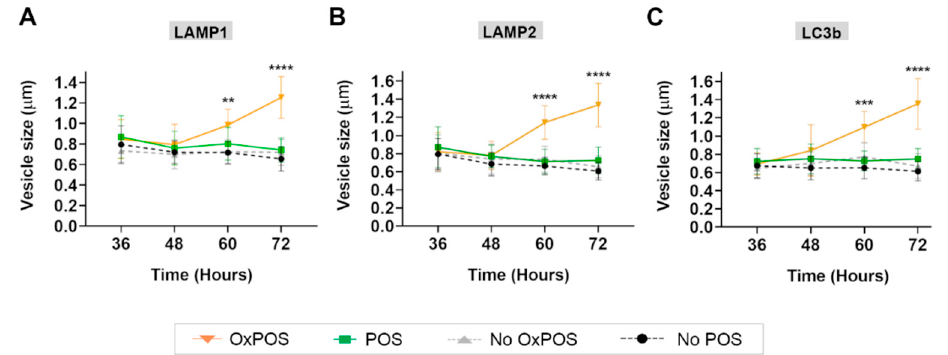
Figure 3. The effects of different cargo-types on the size of autophagy-lysosomes in RPE cells. The diameter of vesicles with and without POS or OxPOS was quantified in blinded confocal images at late time points and shown for ( A ) LAMP1, ( B ) LAMP2 and ( C ) LC3b. Significant differences were observed showing OxPOS associated with enlarged early and mature lysosomes at 60–72 h, compared to equivalent compartments without cargos in the same culture. Similarly, LC3b bodies trafficking OxPOS were also swollen by 60–72 h compared to autophagy vacuoles without these cargos in the same culture. The extent of swelling in OxPOS-carrying vesicles was considerable, which significantly increased in diameter compared to vesicles carrying POS or those without any cargos. Data from a minimum of 5 measurements from each of 9 fields of view and at least n = 10 cells/field per time point. Statistical comparisons using a two-way ANOVA followed by Tukey’s multiple comparison test, where significant differences are indicated as p ≤ 0.01 (**), p ≤ 0.001 (***) and p ≤ 0.0001 (****).